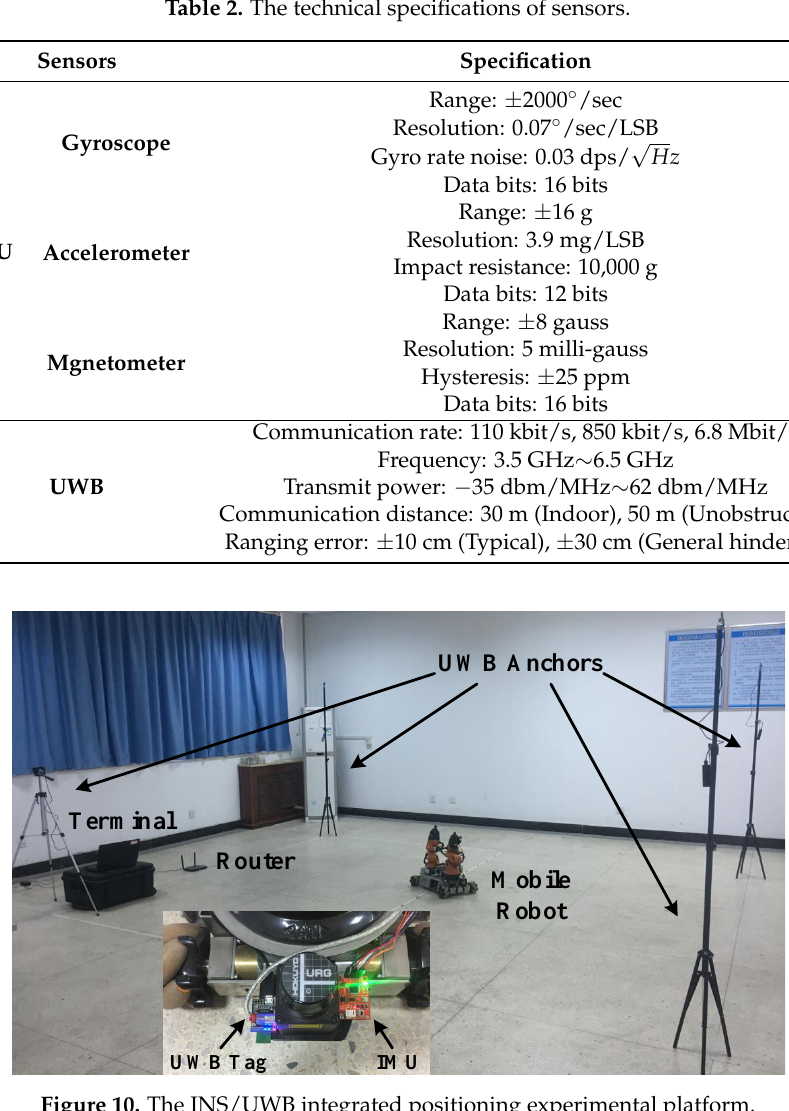
Figure 10. The INS/UWB integrated positioning experimental